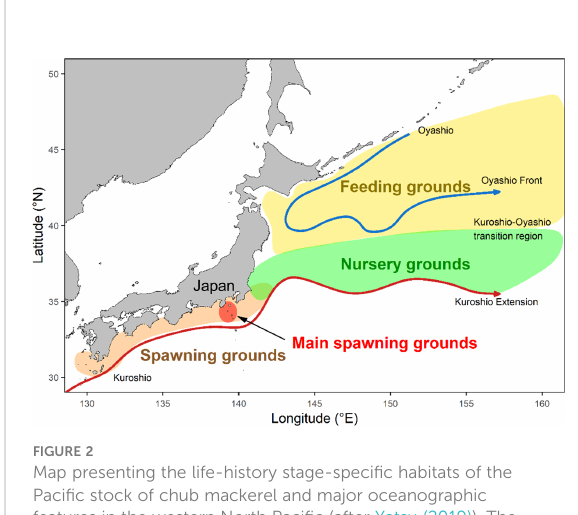
FIGURE 2 Map presenting the life-history stage-speci fi c habitats of the Paci fi c stock of chub mackerel and major oceanographic features in the western North Paci fi c (after Yatsu (2019)). The main spawning grounds are located in the waters around Izu Islands, western Japan. The Kuroshio current contains warm water while the Oyashio current contains subarctic and highly productive water. The nursery and feeding grounds are in the Kuroshio-Oyashio transition region, consisting of a mixture of water from these two